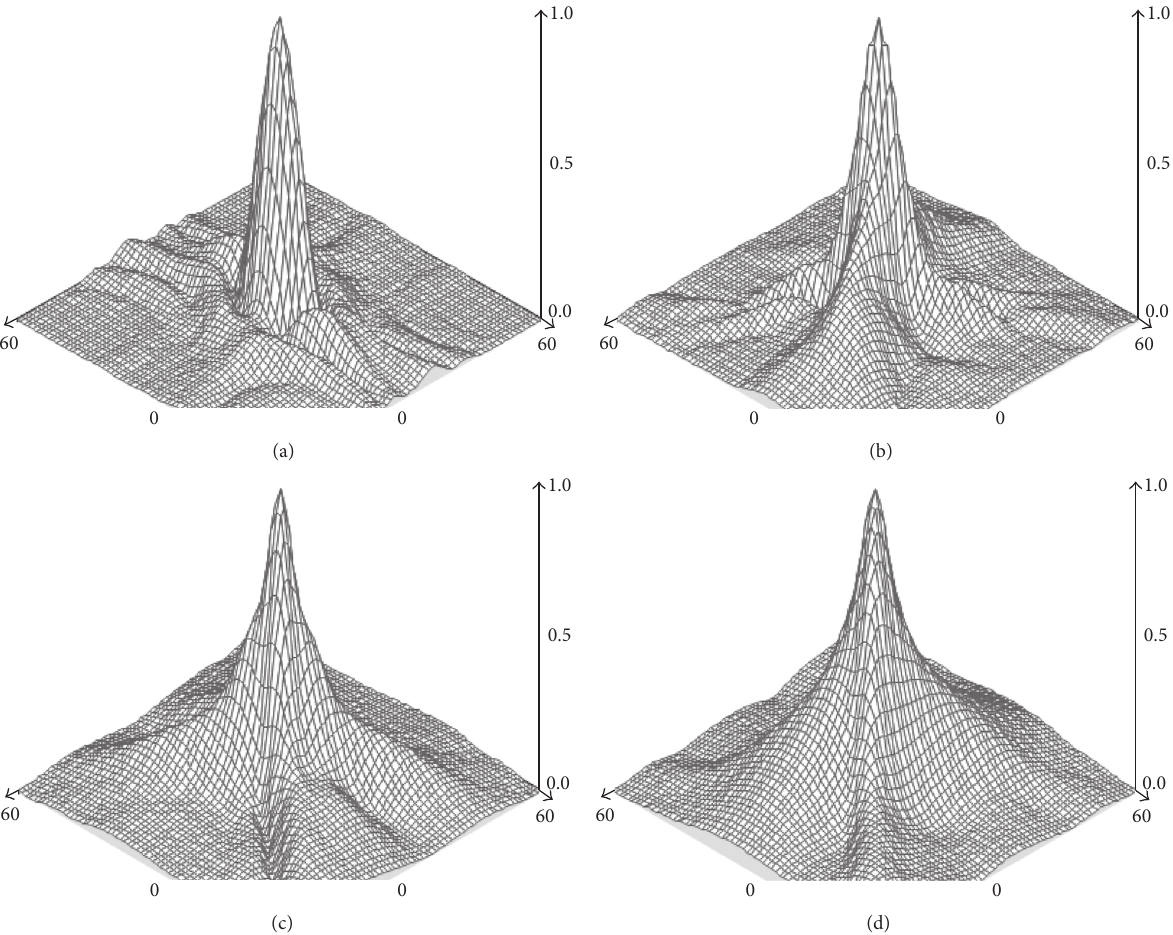
Figure 5: The three-dimensional images of MTF values ((a) before procedure; (b) 1 week after procedure; (c) 1 month after procedure; (d) 3 months after SMILE procedure).